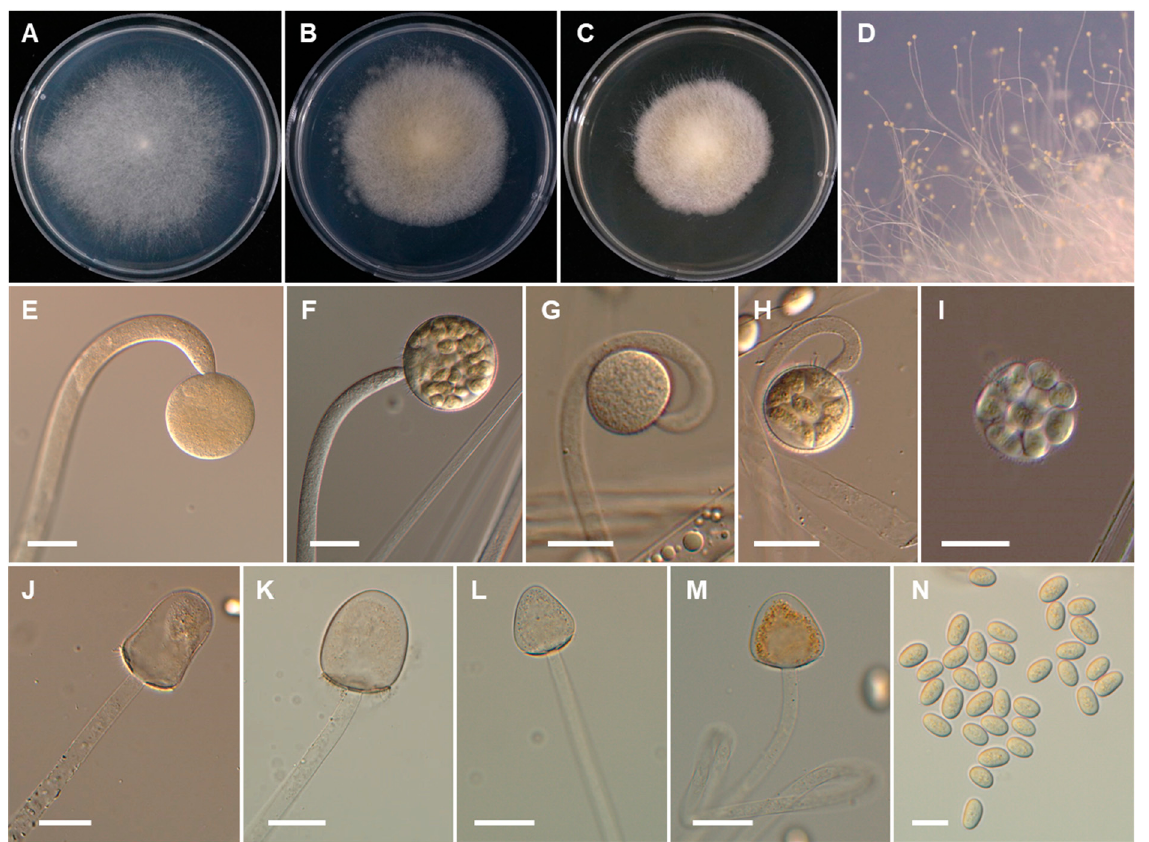
Figure 5. Morphology of Backusella thermophila . A , Colony on SMA. B , Colony on PDA. C , Colony on MEA. D , Sporangiophores forming sporangia. E–H , Young and mature sporangia. I , Multi-spored sporangiolum. J–M , Columellae of various shapes. N , Sporangiospores. Scale bars = 20 μ m.